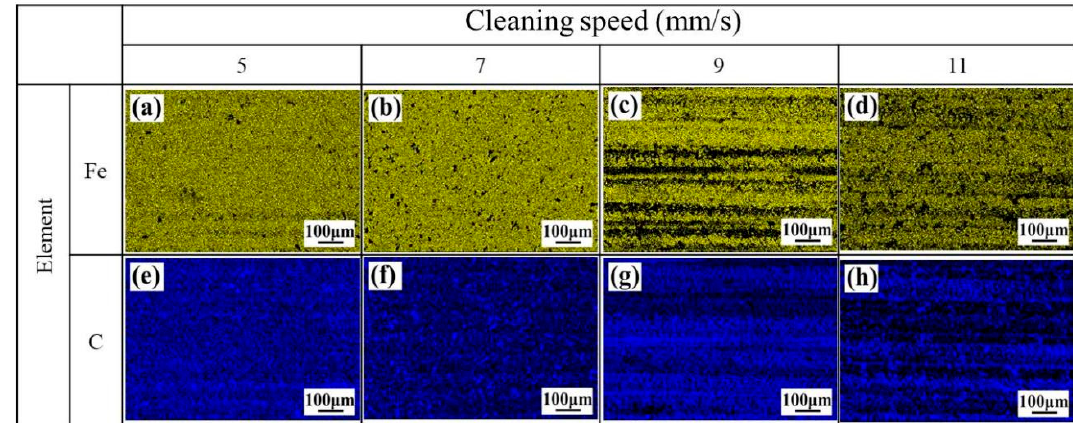
Figure 9. The effect of laser Y-moving speed on the distribution of the elements in the cleaned surface during laser cleaning. ( a ) Fe, at 5 mm/s; ( b ) Fe, at 7 mm/s; ( c ) Fe, at 9 mm/s; ( d ) Fe, at 11 mm/s; ( e ) C, at 5 mm/s; ( f ) C, at 7 mm/s; ( g ) C, at 9 mm/s; ( h ) C, at 11 mm/s.